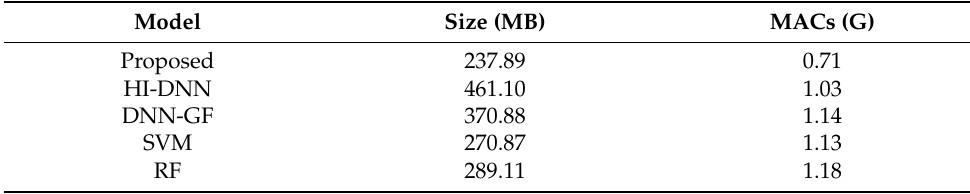
Table 7. Computation Cost and Memory Analysis of Different Techniques.